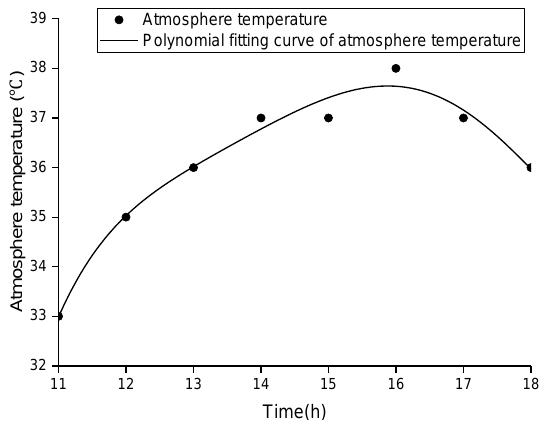
Figure 10. Atmosphere temperatures.